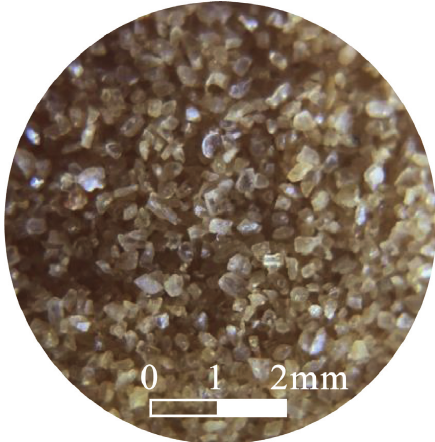
Figure 2: Experimental material.